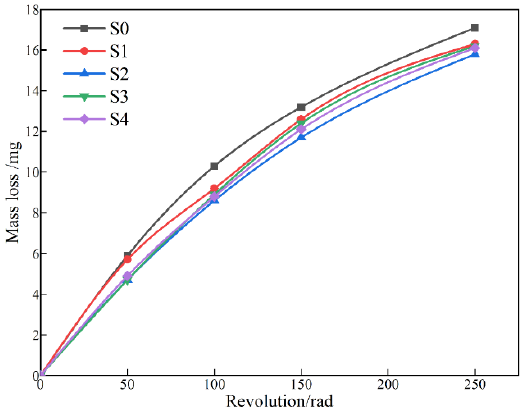
Figure 9. The mass loss of MAO